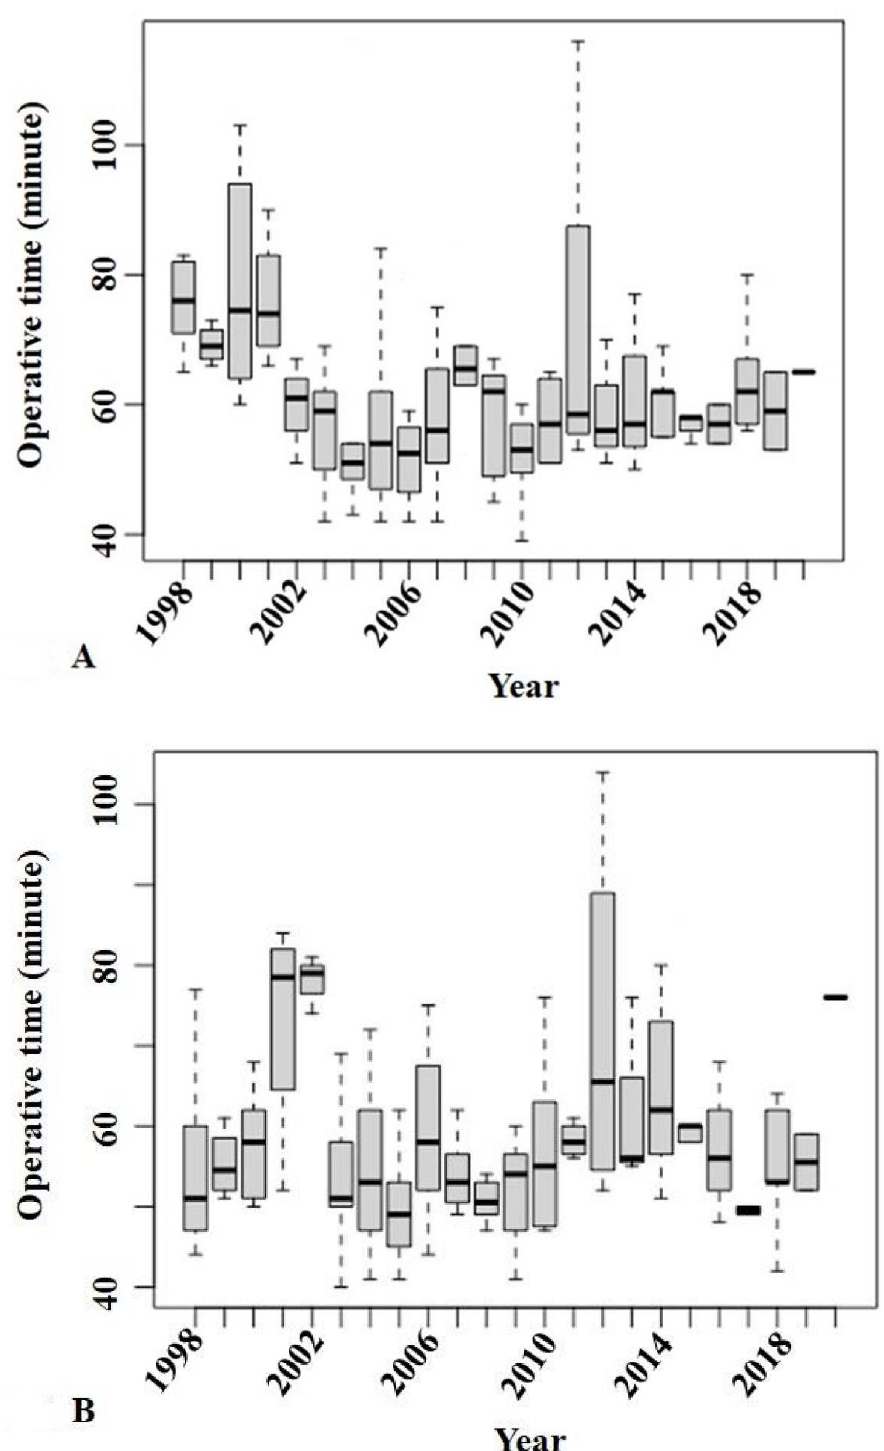
Figure 2. The Jonckheere – Terpstra test showed a significant trend in decreasing operative time with calendar year for surgeries on the left side ( p = 0.037) ( A ) but not the right side ( p = 0.795) ( B ). The correlations between operative time and the variables are shown in Table 3. BH, BW (Figure 3), and BMI had weak correlations (r = 0.212, p = 0.001; r = 0.352, p < 0.001; and r = 0.290, p < 0.001, respectively) with operative time (Table 3). However, the other variables, namely sex, age, HSS score, TFA, and order of surgery showed no